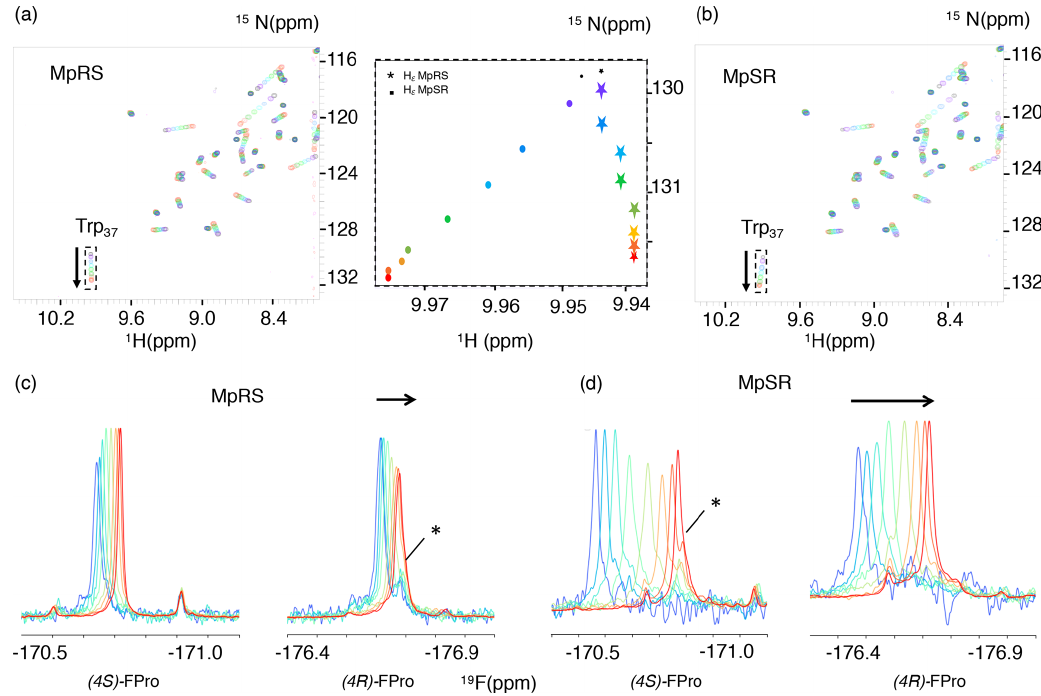
Figure 6. (a, b) A series of 1 H– 15 N HSQC spectra of Vinexin β SH3.3 domain recorded upon successive addition of MpRS (a) and MpSR (b) peptides. The black spectrum corresponds to the first titration point where no peptide is added, while the red spectrum corresponds to the last titration point. The arrows indicate the tryptophan-37 N ε –H ε cross-peak trajectories during the titration. The insert in the middle displays a zoom-in view of these cross-peak trajectories shown as the position of the peak centre for both MpRS (stars) and MpSR (discs) peptides. (c, d) Series of 1D 19 F spectra recorded during the same titration experiment of Vinexin β SH3.3 domain by MpRS (c) and MpSR (d) peptides. Peak intensities were normalized to account for the difference in peptide concentrations and number of scans used to record the spectrum. For the (4 R )-FPro4 in MpRS and (4 S )-FPro4 in MpSR, a minor peak that overlaps with the main peak at high peptide concentrations is indicated by an asterisk. At low peptide concentrations (blue) the spectra are indicative of a mostly bound form, while at high peptide concentrations (red) the spectra converge to those observed for the free